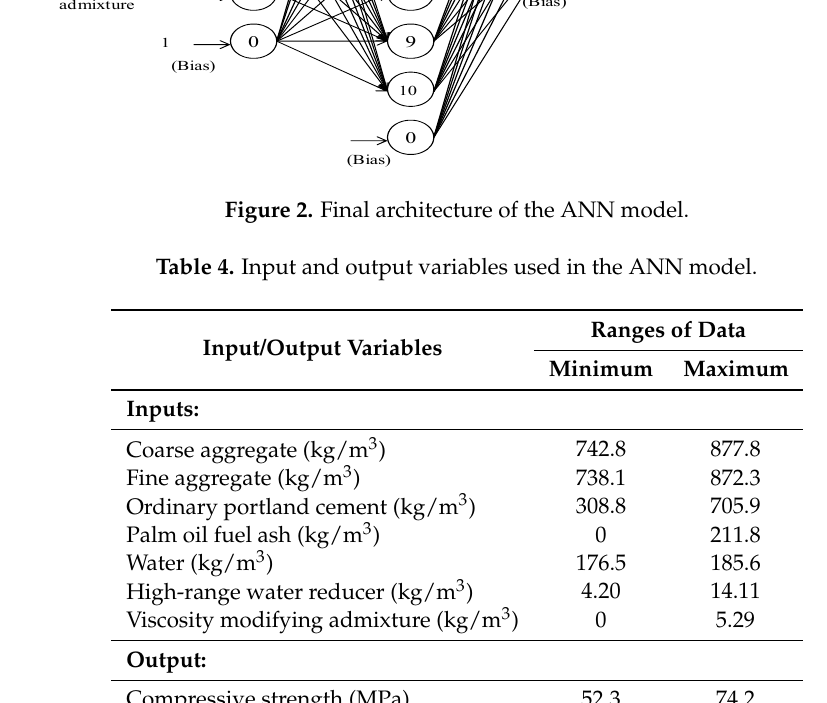
Table 5. Details of the mix proportions and compressive strength values of concretes used in the training process of the ANN model.